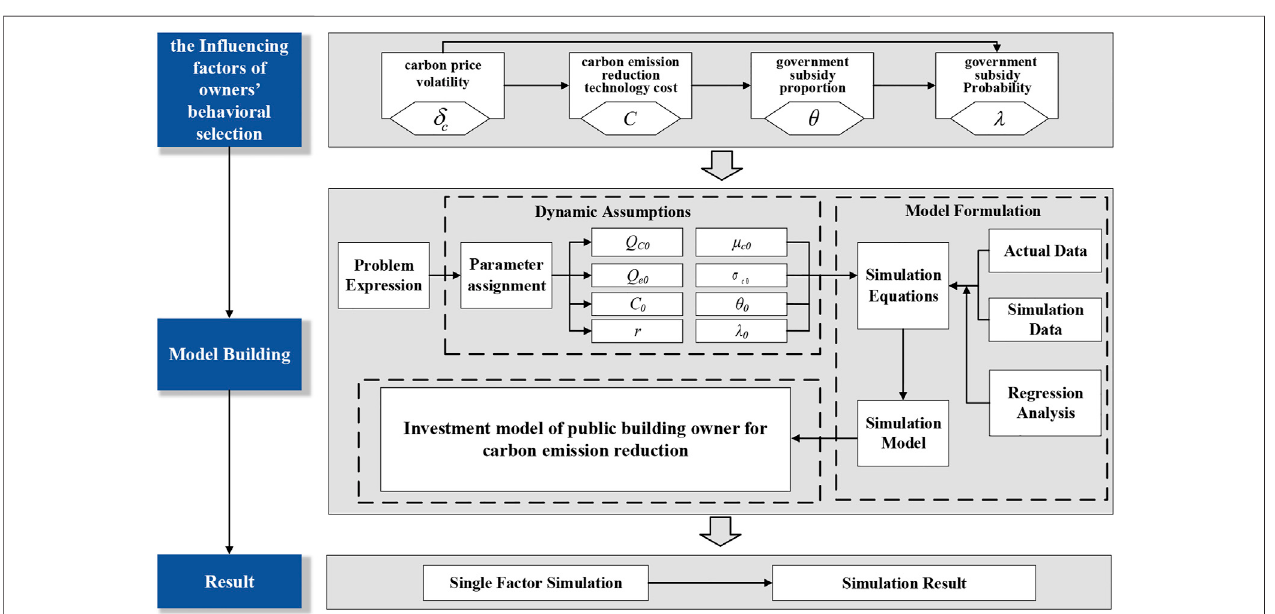
FIGURE 3 | Model-building process.